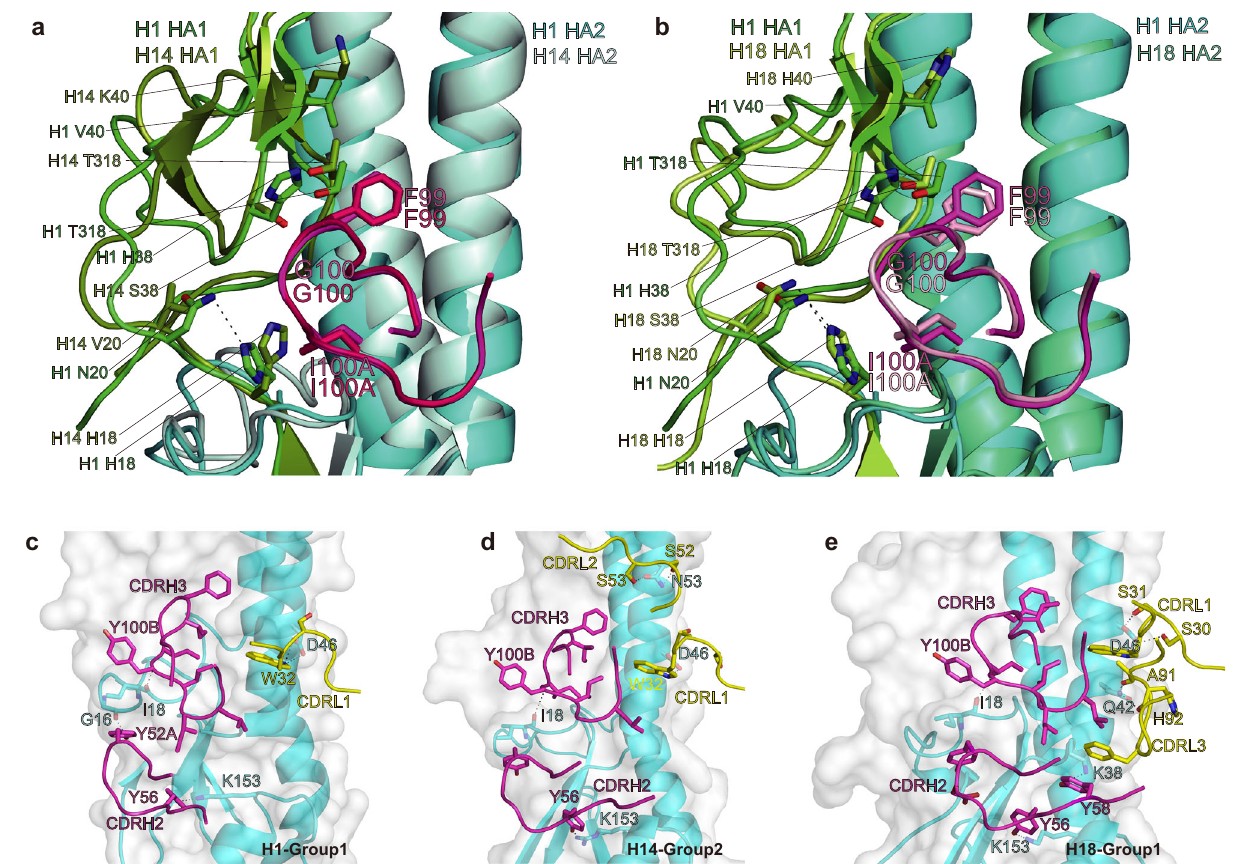
Fig.4|PN-SIA28bindstodifferentHAproteinswithauniquebindingmodality. a-b PN-SIA28 interactions with HA1 of H1, H14, and H18. ( a ) Overlay of PN-SIA28 bound to group 1 (H1) and group 2 (H14) HA proteins. HA1 and HA2 of H1 are colored green and cyan, and HA1 and HA2 of H14 are colored split pea and pale cyan, respectively. The CDRH3 of PN-SIA28 binding to H1 is colored magenta, and theCDRH3ofPN-SIA28bindingtoH14iscolored hotpink.( b )Overlayof PN-SIA28 bound to group 1 (H1) and group 2 (H18) HA proteins. The components of the PN- SIA28/H1HAcomplexarecoloredaccordingto( a ).HA1andHA2ofH18arecolored